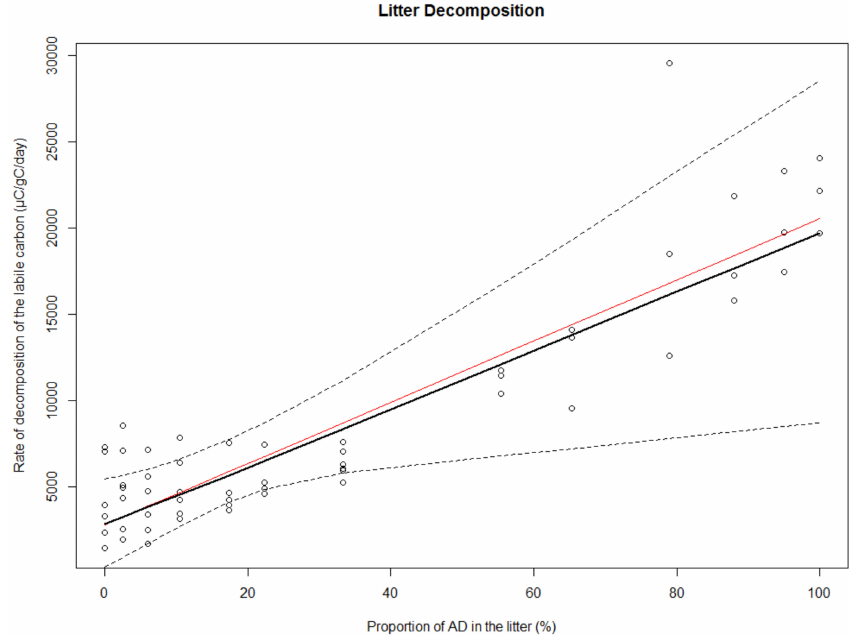
Figure 4. The relationship between the rate of labile carbon decomposition and of the nitrogen fixed A. dealbata in the litter. The red line represents the initial linear regression model to the median points ( R 2 : 81.8%), and the black line shows the median of the resampled points ( R 2 : 81.7%). Dotted lines represent the confidence bounds for the resampled